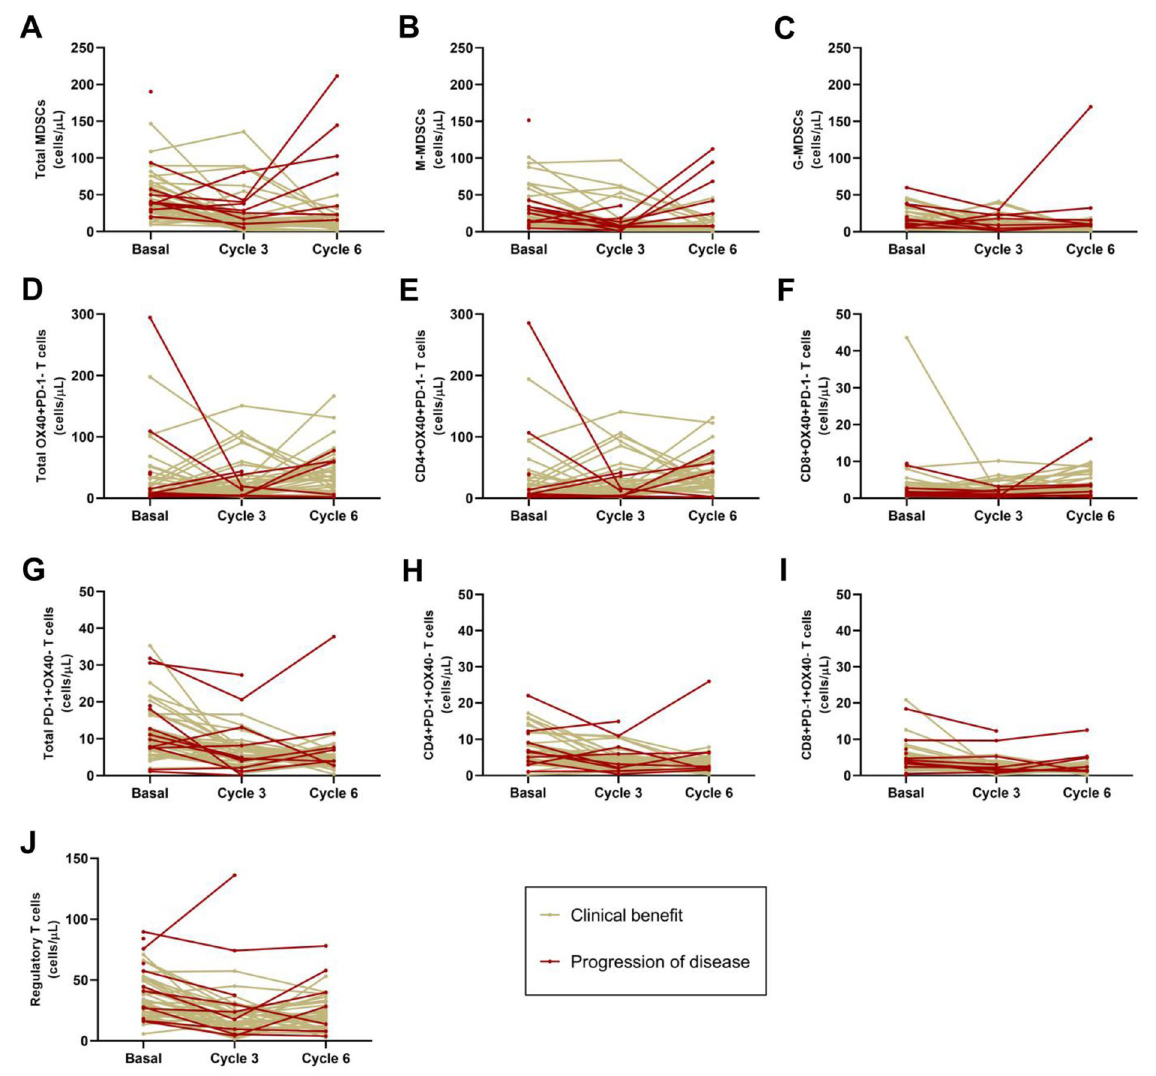
Figure 6. The dynamic response for each patient. In particular, each line represents the response trend from basal to C6. Red and yellow lines represent patients with progression of disease and clinical benefit, respectively. MDSCs, myeloid derived suppressor cells; M‑MDSC, monocytic MDSCs; G‑MDSC, granulocytic MDSCs